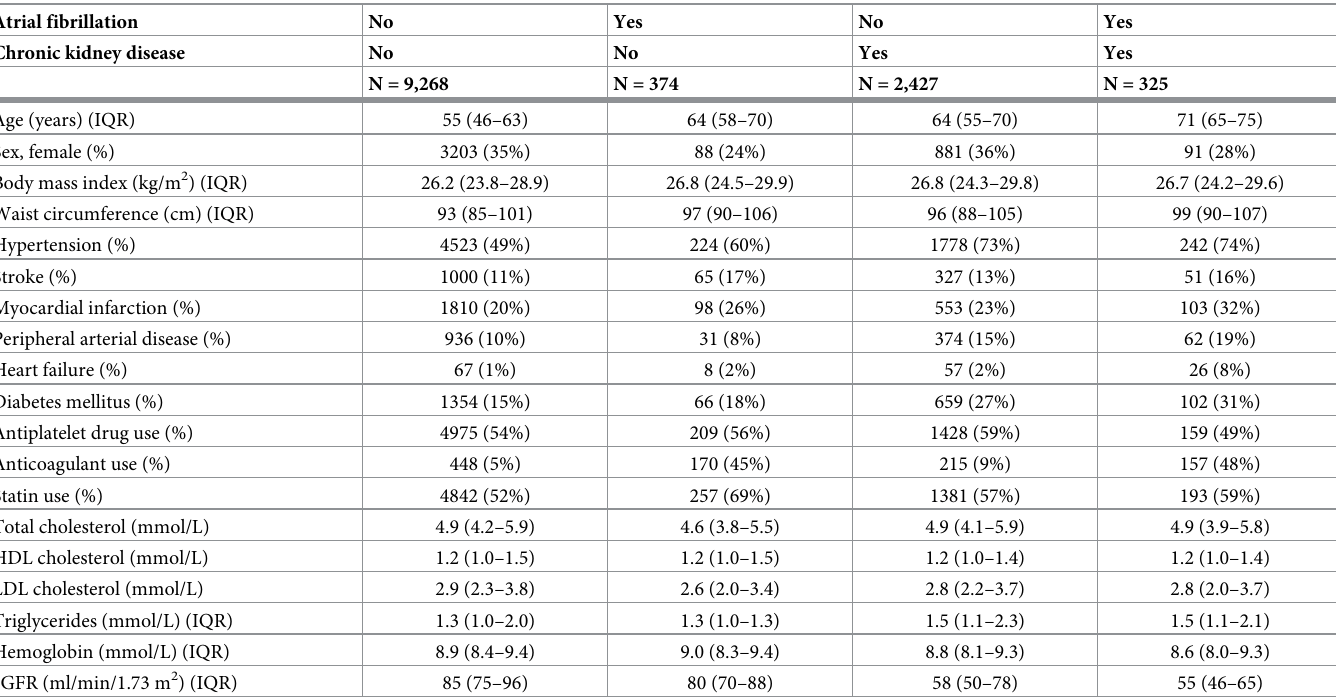
Table 1. Baseline characteristics.